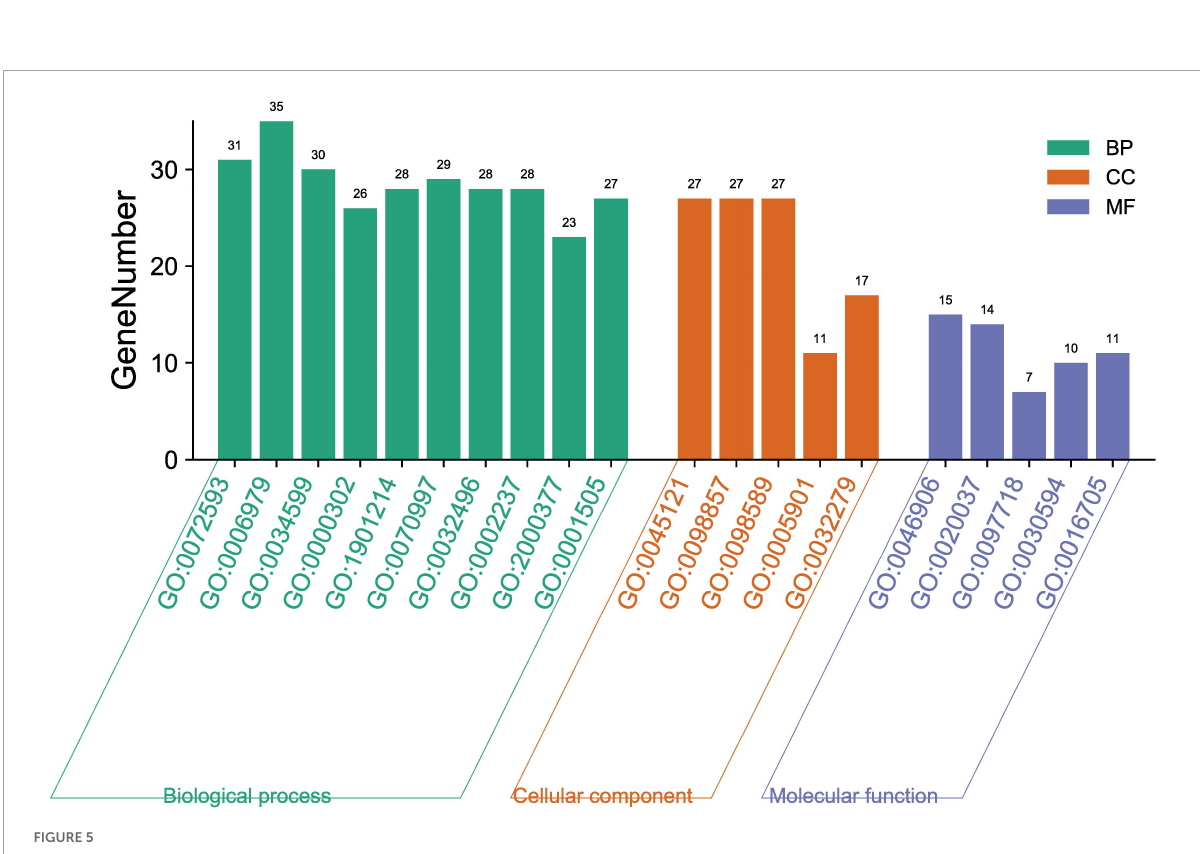
FIGURE5 GO enrichment analysis of putative targets of QZZD against